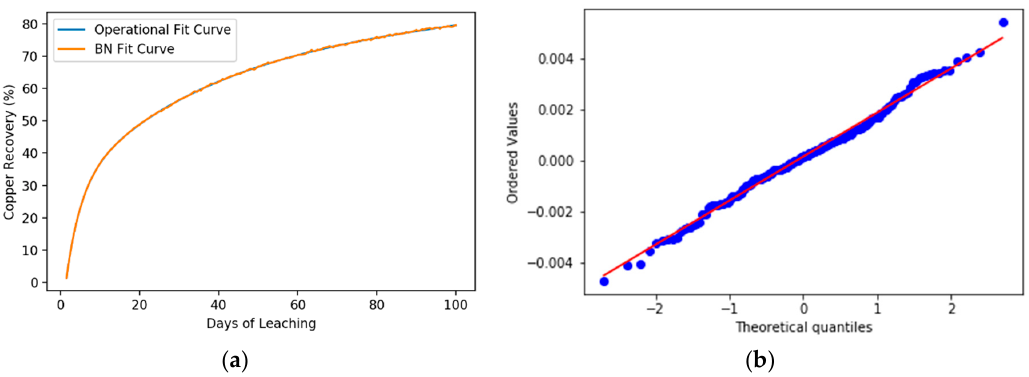
Figure 8. Operational fit curve versus Bayesian networks outputs ( a ) and Normal Probability Graph 𝐸[𝑌(𝑡)|𝑋 (cid:3041) ] ( b ). Table 2. Statistics of the analytical model of leaching of marine nodules.